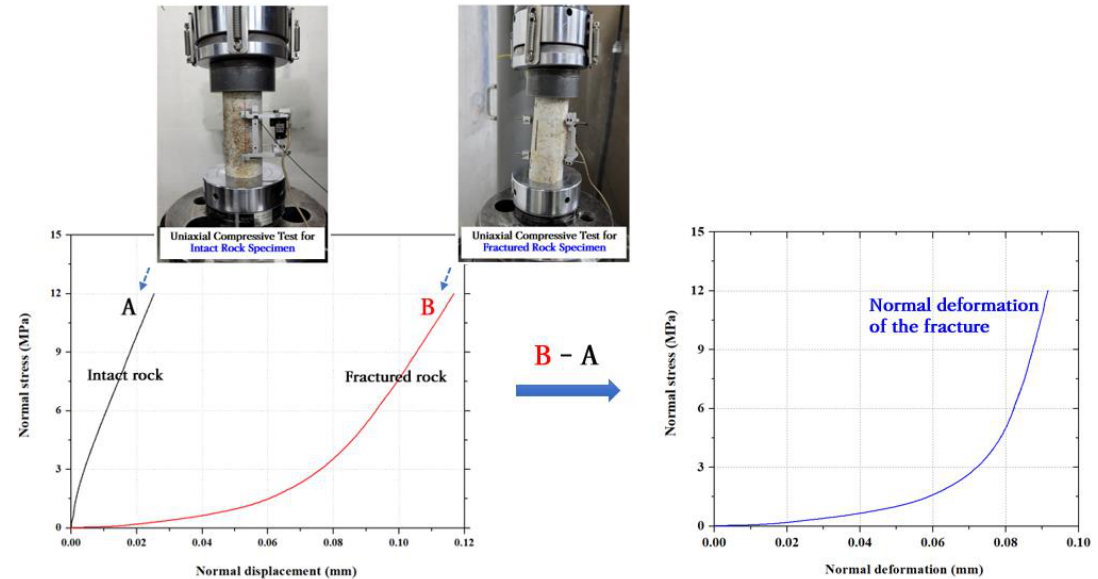
Figure 3. Schematic of data analysis to derive the normal deformation data of the rock fracture.